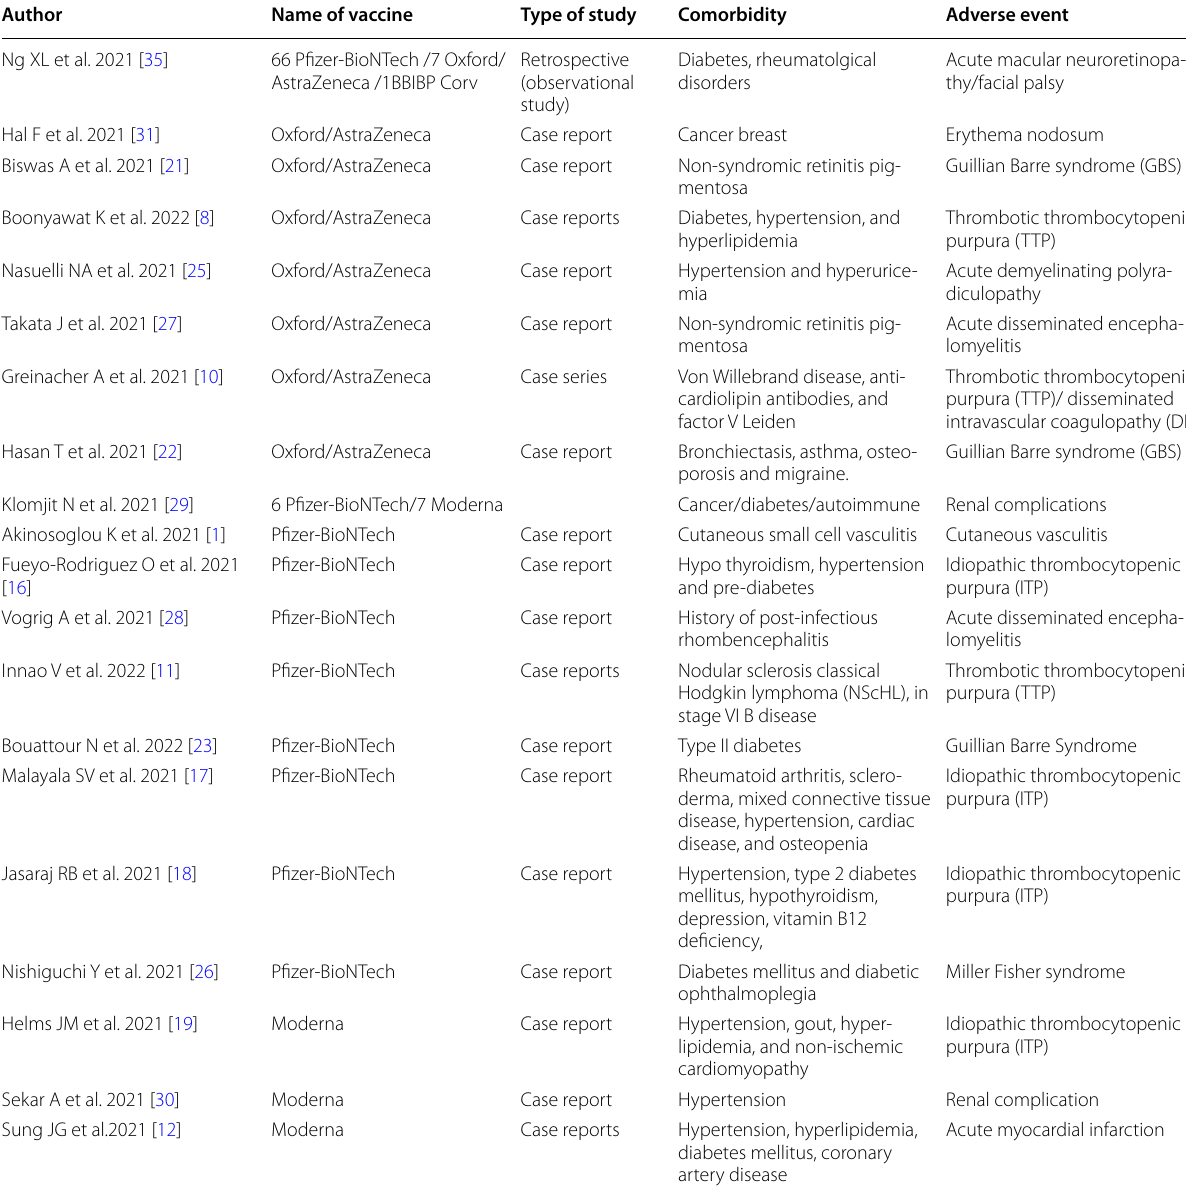
Table 5 Studies that showed comorbidities of involved vaccinated